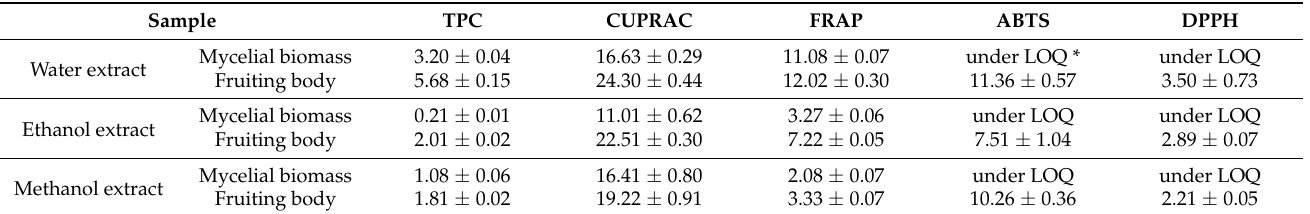
Table 2. Total phenolic content (TPC, mg GAE/g DW) and antioxidant potential (CUPRAC,